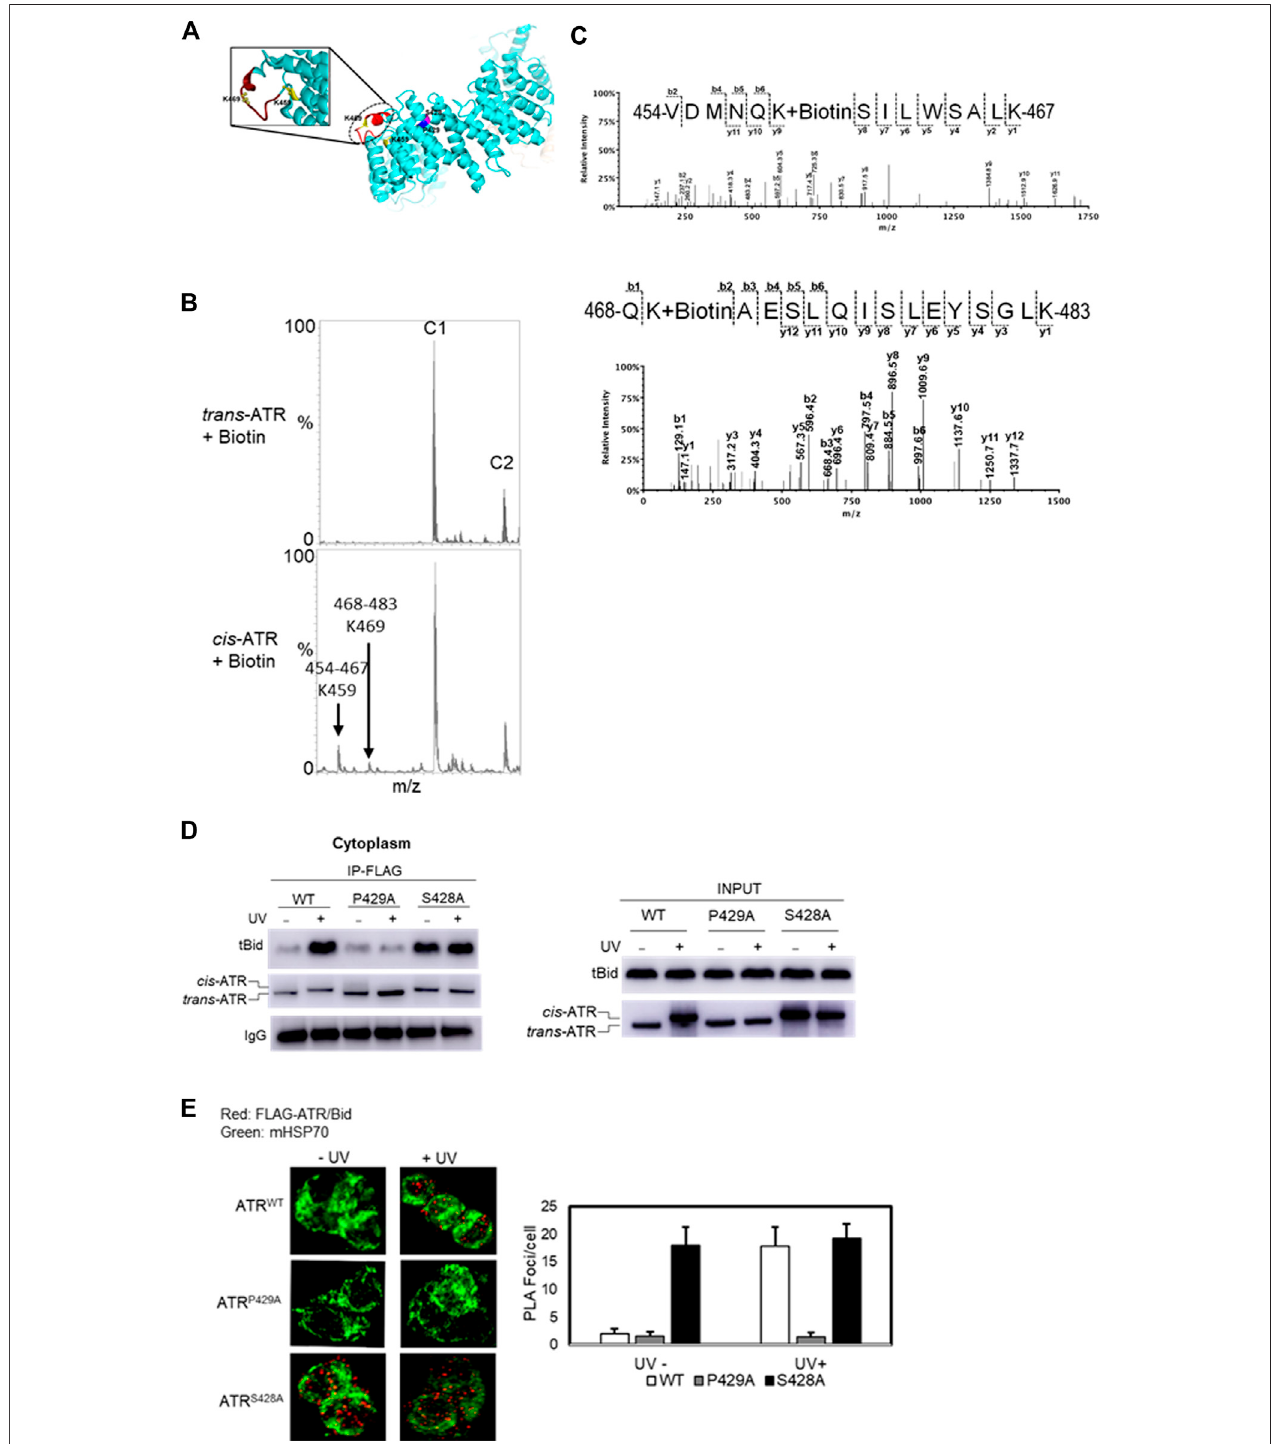
FIGURE 3 | Effect of cis/trans conformation of ATR on ATR – tBid interaction. (A) In ribbon diagram of ATR (PDB code 5YZ0, Rao et al., 2018), the positions of S428A and P429A mutant sites on the ATR (chain colored with cyan) structure are colored with magenta and blue, respectively. tBid interactingwith the BH3domain of ATR is shown by red color marked with a dotted circle. Biotin-modi fi ed K459 and K469 amino acids of cis -ATR are displayed by ball and stick. (B) Representative segment of MALDI-TOF data showing that K459 and K469 were readily modi fi ed with sulfo-NHS-LC-biotin in cis-ATR but were signi fi cantly protected from the modi fi cation in trans-ATR. Unmodi fi ed peaks C1 and C2 serve as controls. (C) Mass spectrum of identi fi ed biotin-modi fi ed Lys-459 amino acid of peptide